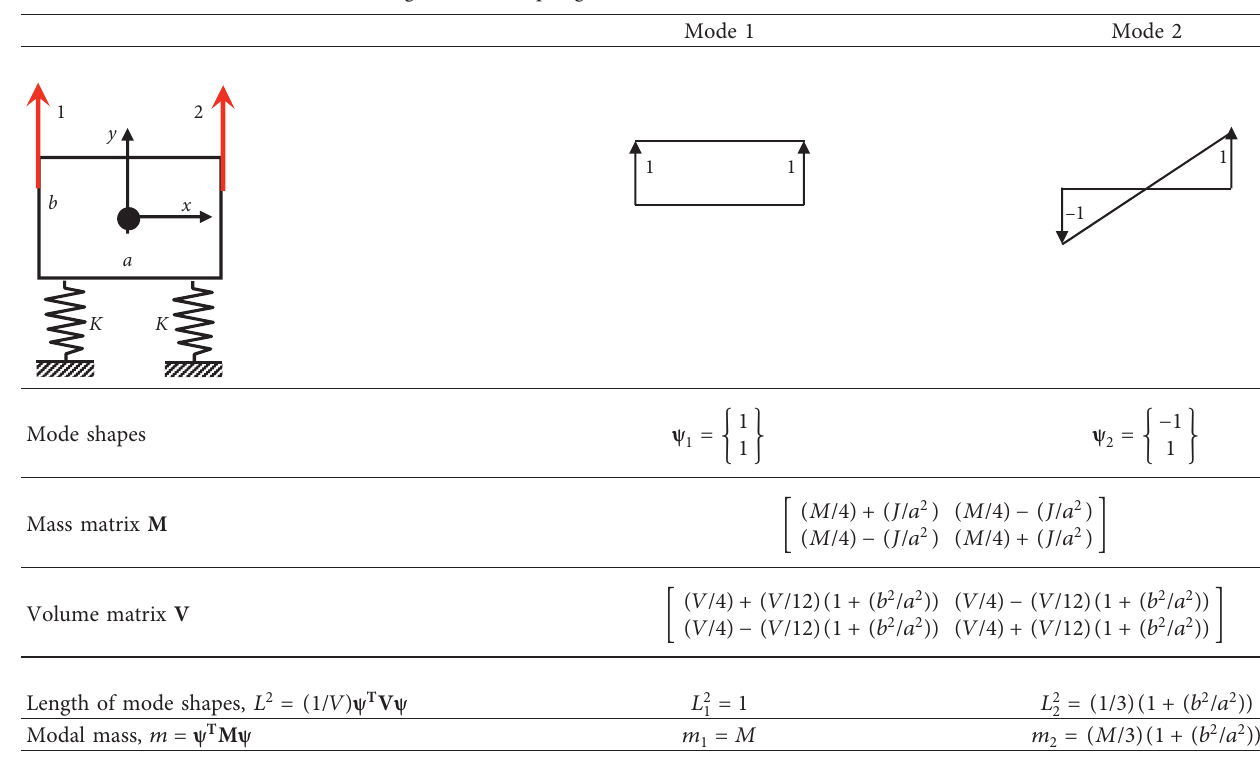
Table 4: A rigid block on springs. Discretization with two translational